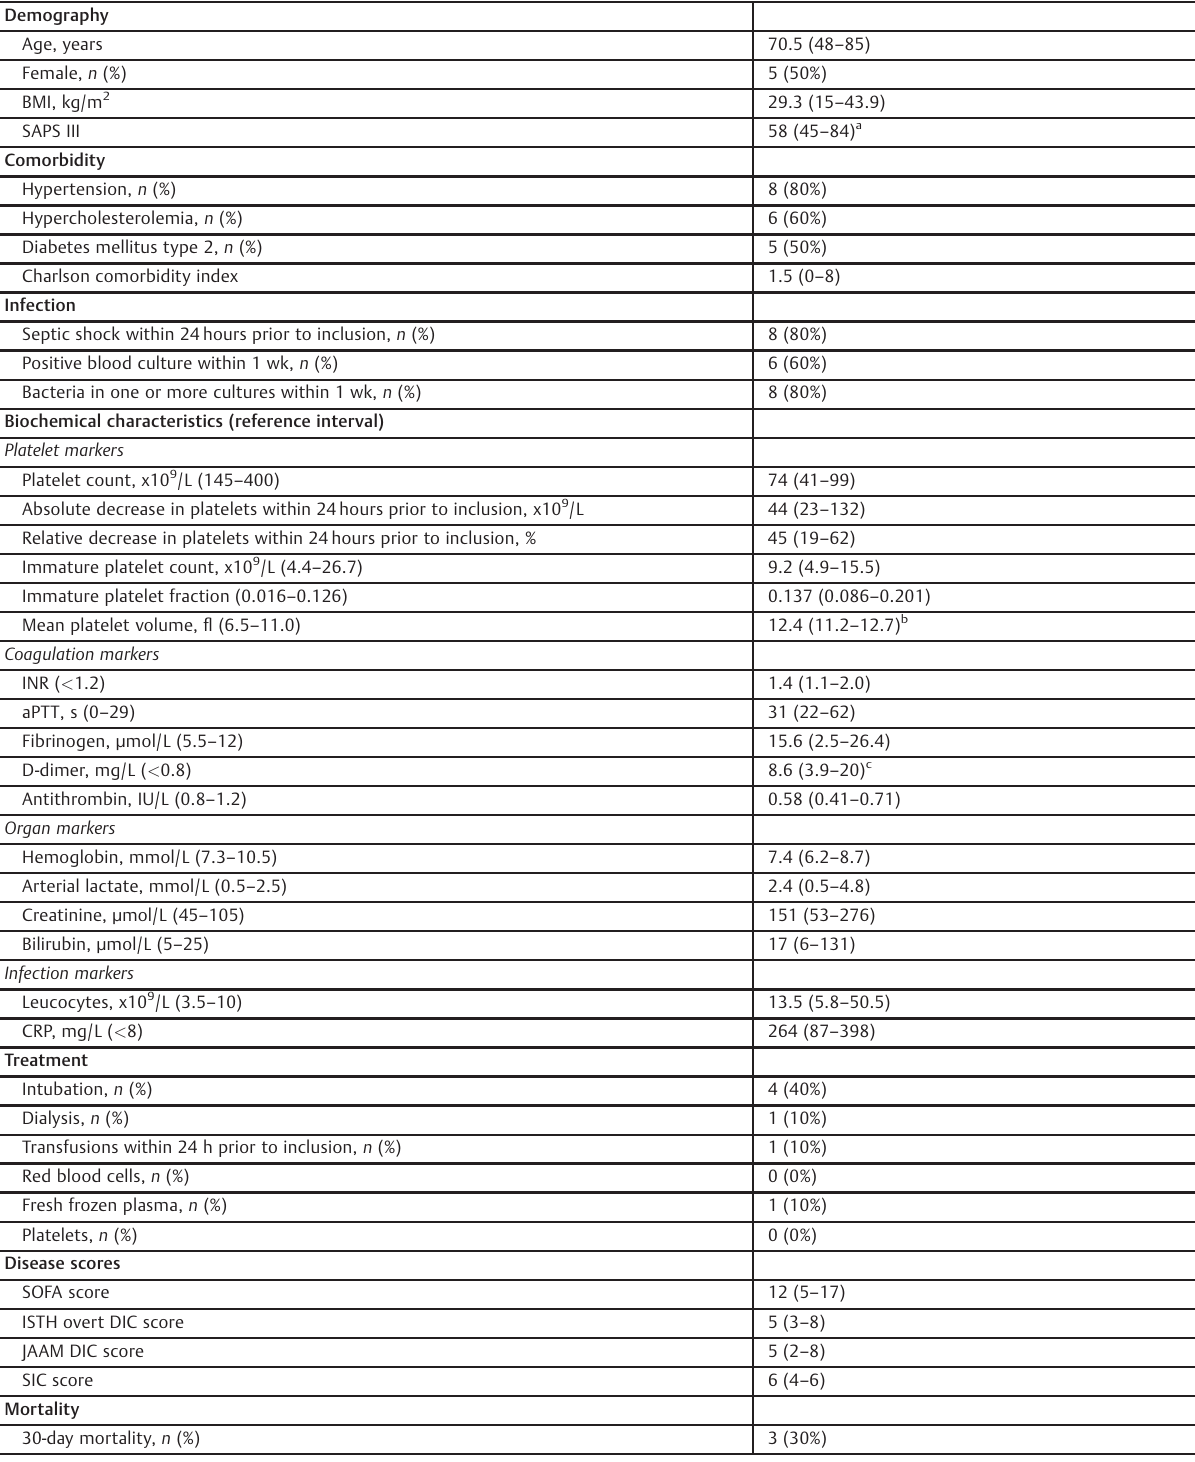
Table 1 Demographic, clinical, and biochemical characteristics of the study population ( n ¼